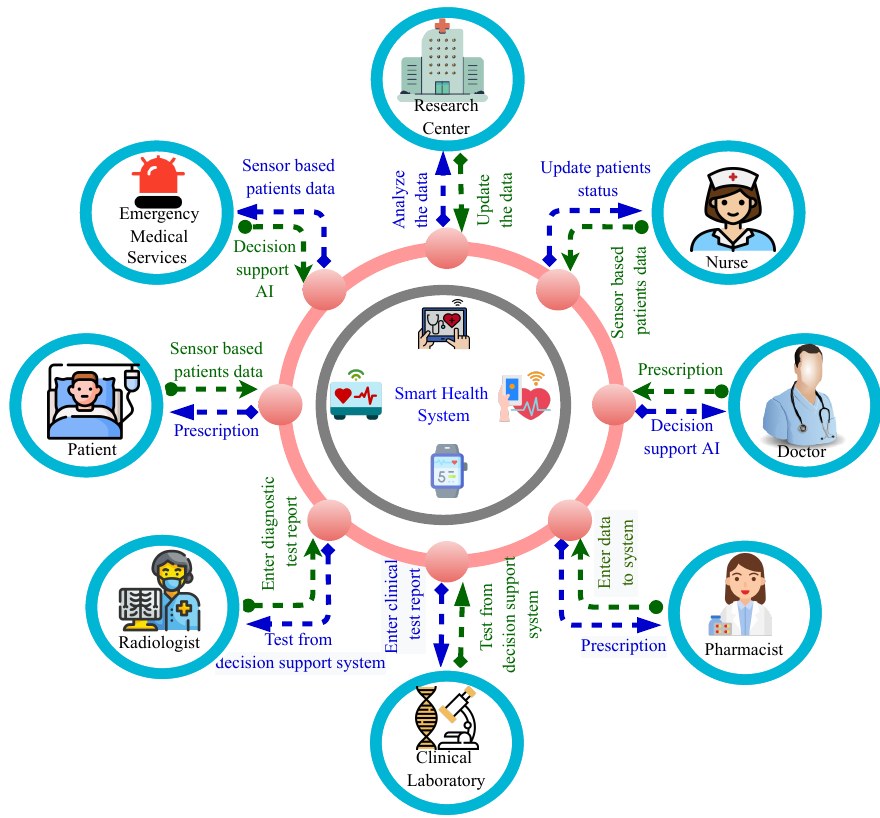
Figure 6. Smart Health Care System in Smart